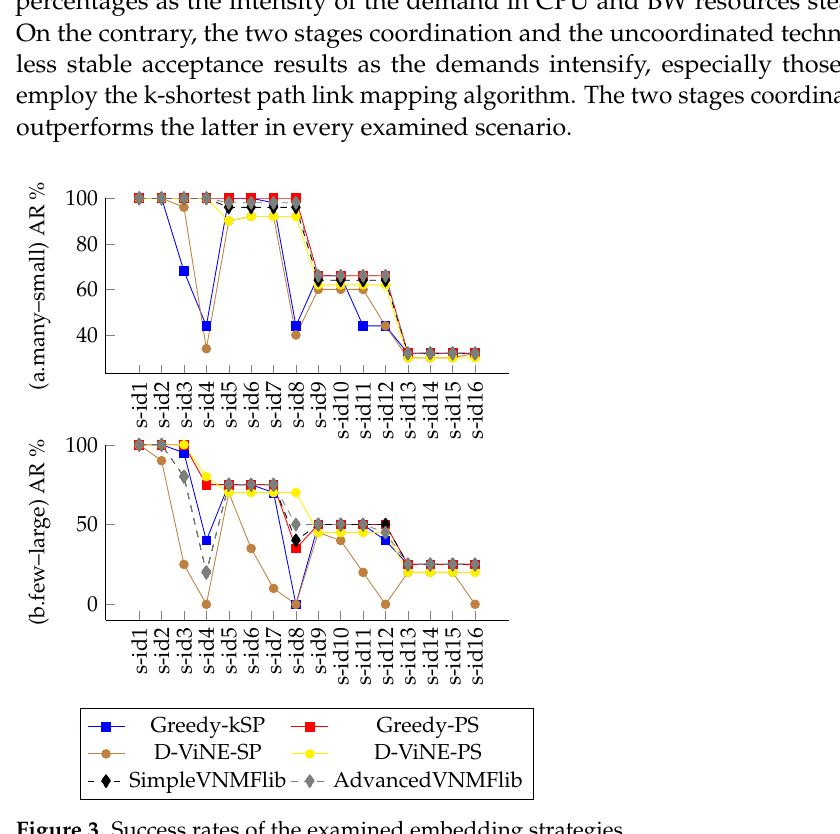
Figure 3. Success rates of the examined embedding